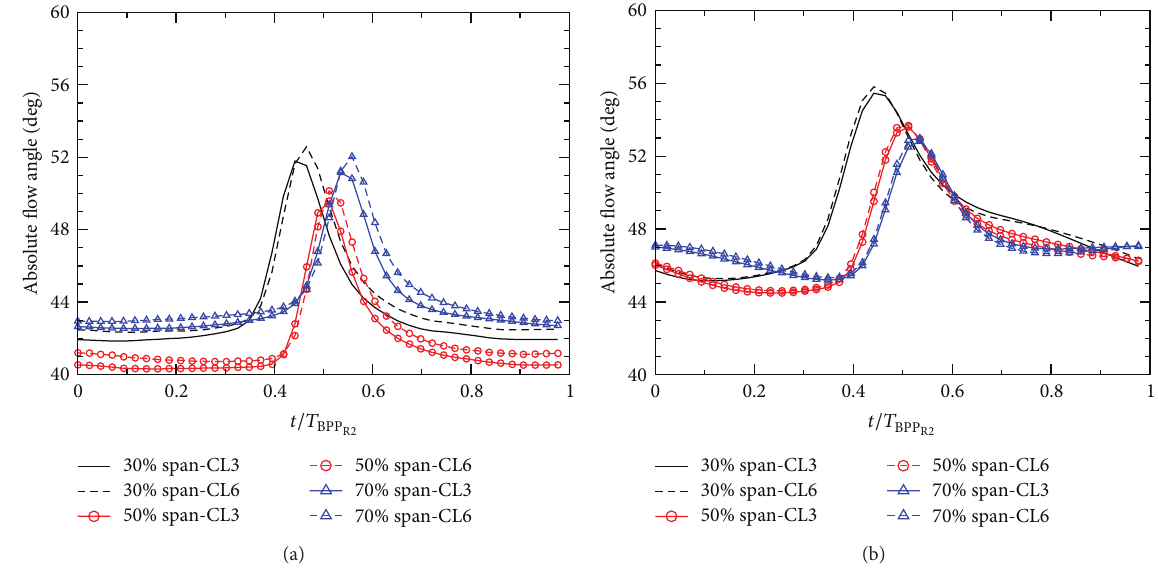
Figure 8: Passage average Rotor 2 wake at design loading (a) and high loading (b).